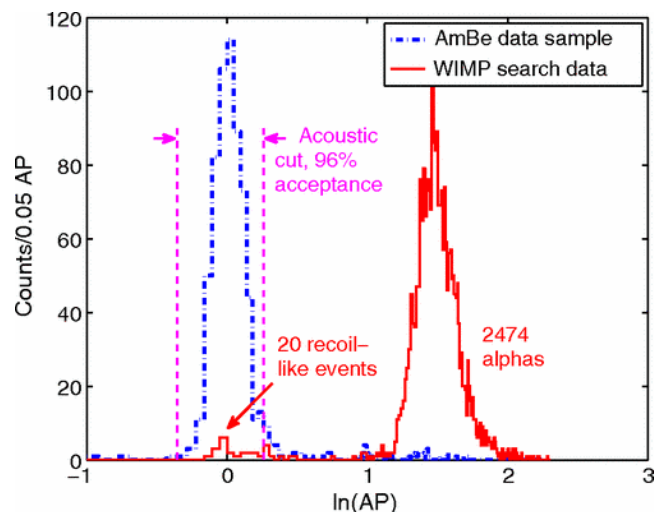
Figure 43: Detector response to alpha particles and nuclear recoils as characterized by an acoustic parameter (AP) in the COUPP-4kg dark matter experiment operated in SNOLAB. Adapted from [ 71 ]